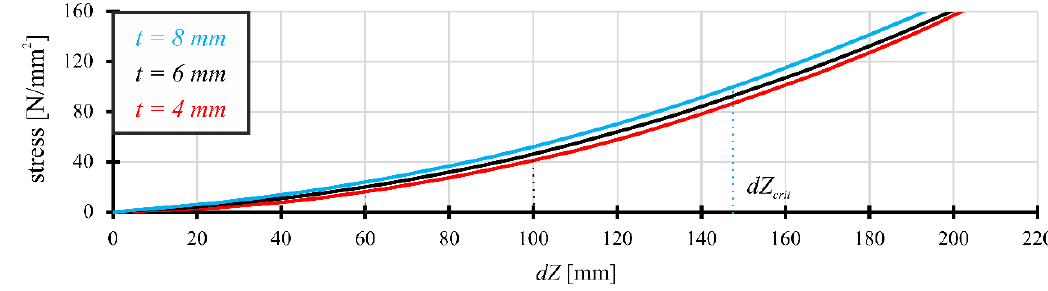
Fig. 10 Maximum principal stresses depending on the cold-bending state, derived from the